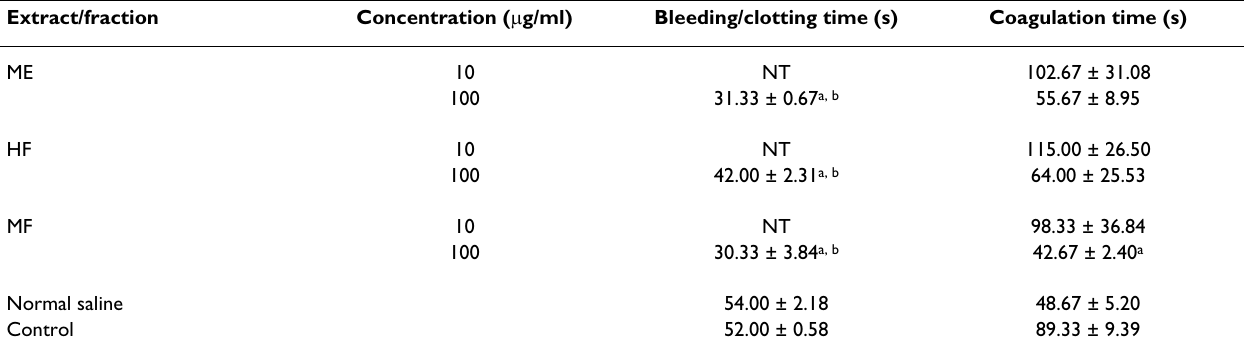
Table 3: Bleeding/clotting and whole rat blood coagulation time Extract/fraction